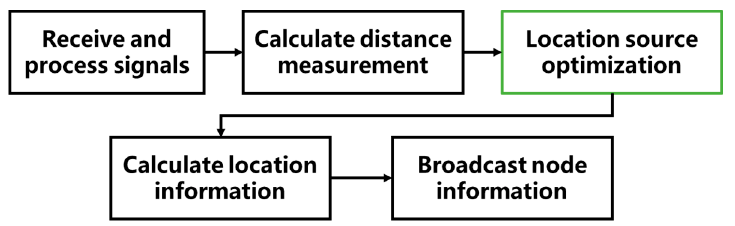
Figure 2. Flow chart of cooperative localization with location source optimization.